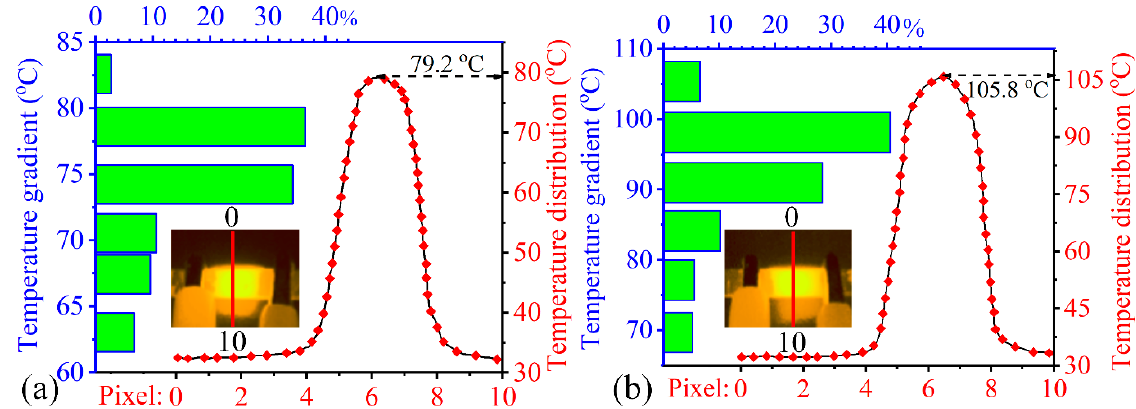
Figure 15. Surface temperature analysis for ( a ) EP/GNPs_1.0 and ( b ) EP/CNT@X+GNPs_5/5 specimens under an applied voltage of 70 V, including the line temperature distribution (dash-dotted line) along the pixel length: 0 → 10 and the statistical distribution (histogram) of surface temperature between two electrodes.